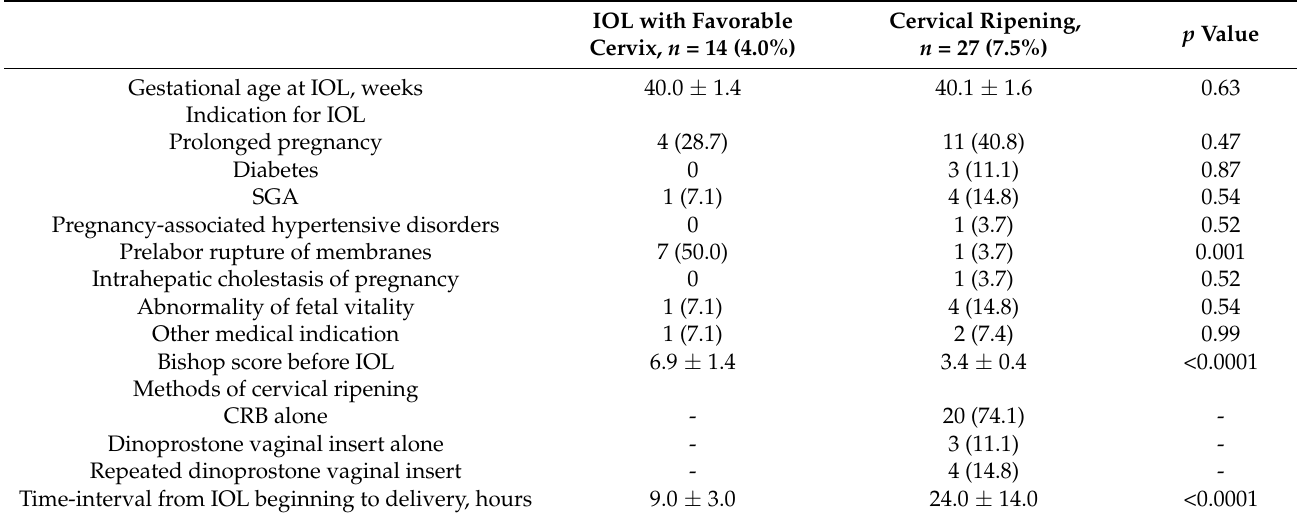
Table 2. Maternal and induction of labor characteristics.